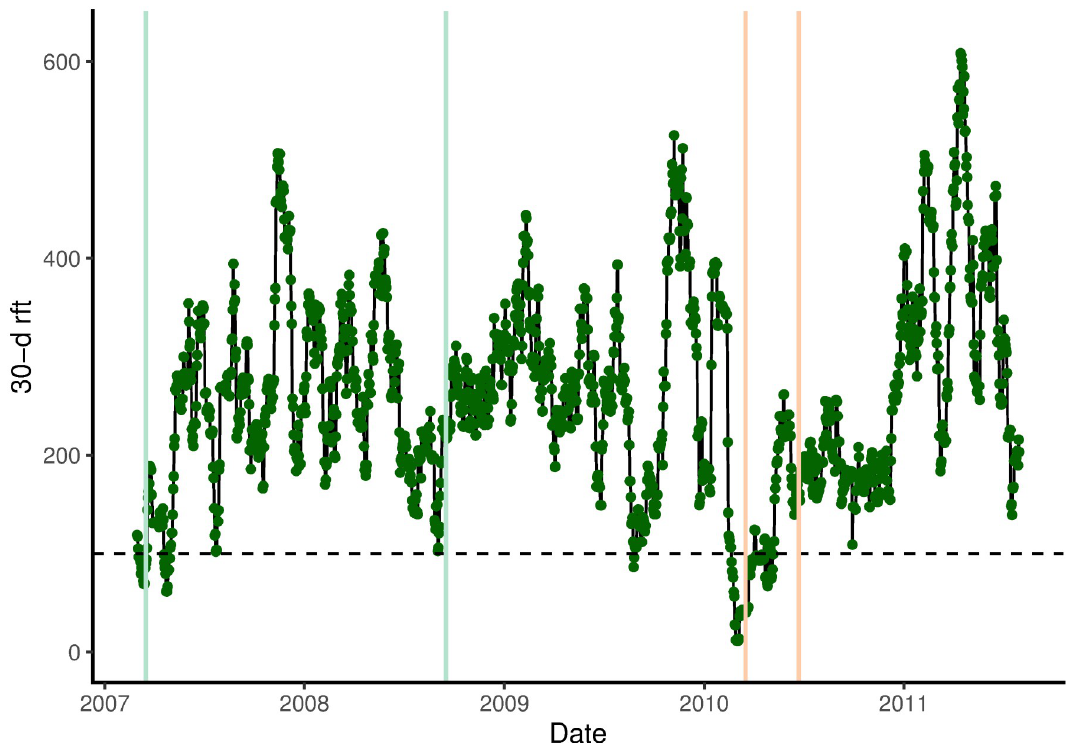
Fig 2. Running 30-day rainfall totals at Danum over the dendroband study period. Wet and dry periods are indicated, between the green and red vertical dashed lines respectively.